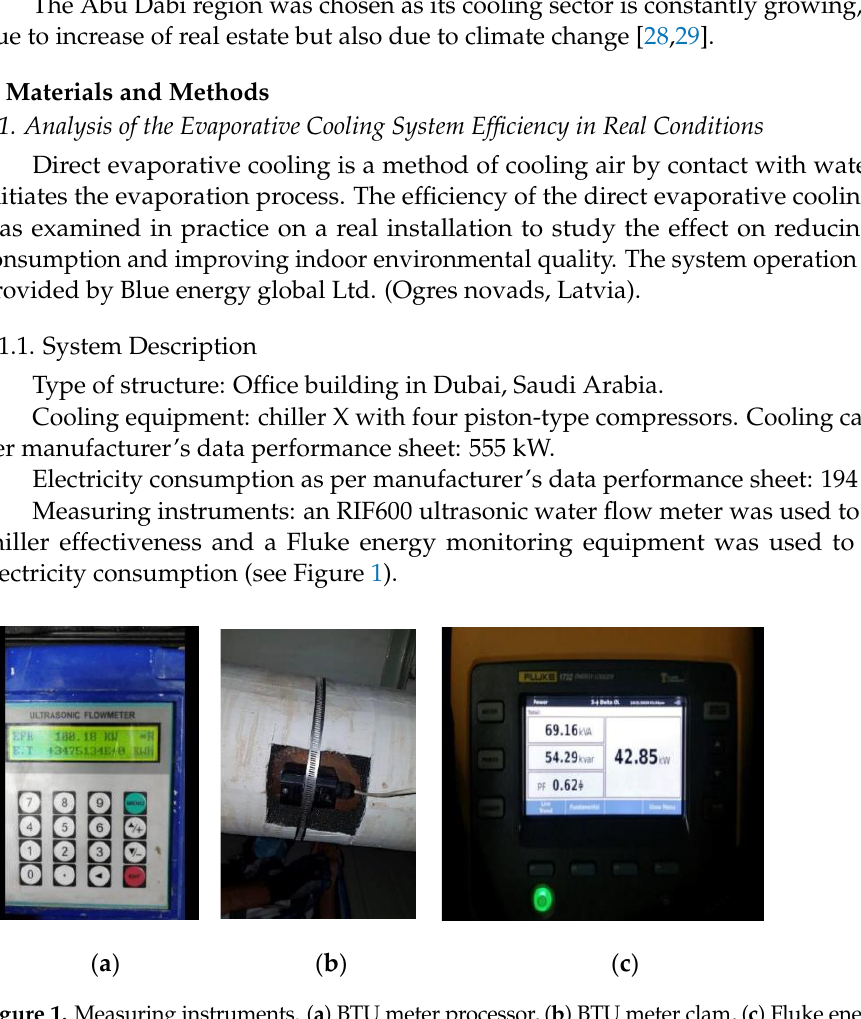
Figure 1. Measuring instruments. ( a ) BTU meter processor, ( b ) BTU meter clam, ( c ) Fluke energy meter